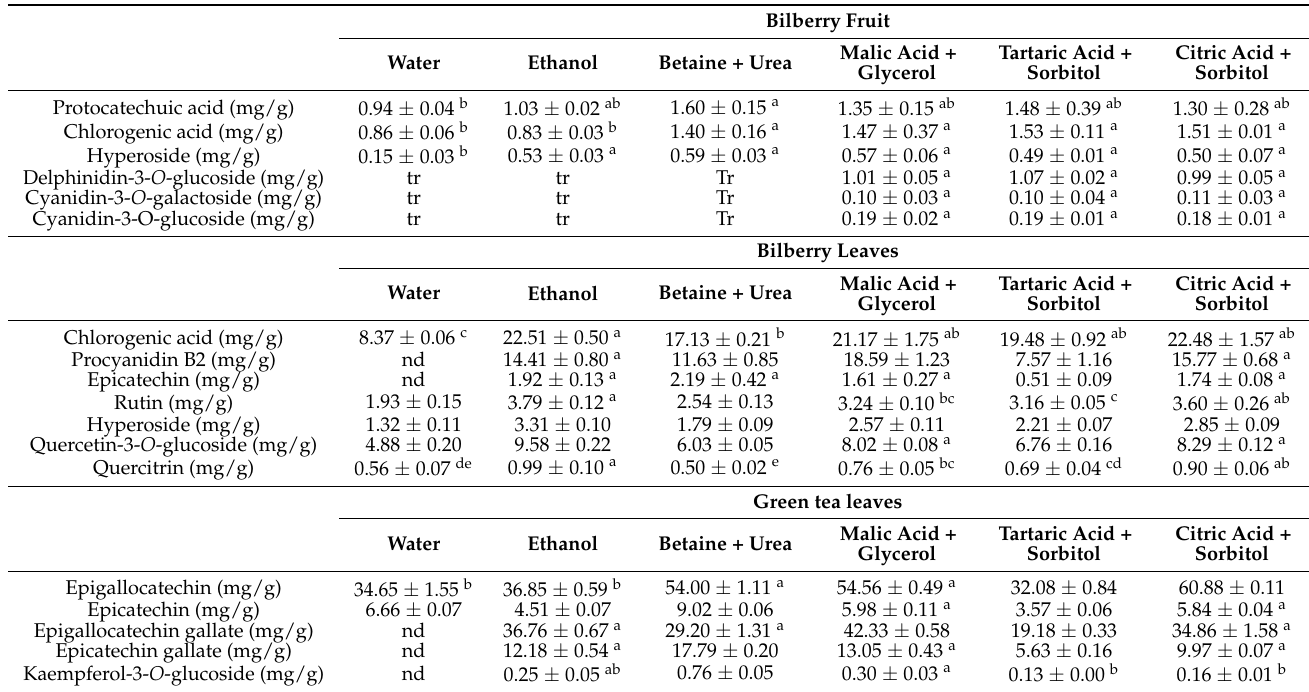
Table 3. Phenolic compounds identified by HPLC analysis in the investigated extracts. Means followed by a common letter are not significantly different at the 95% level of significance ( p <